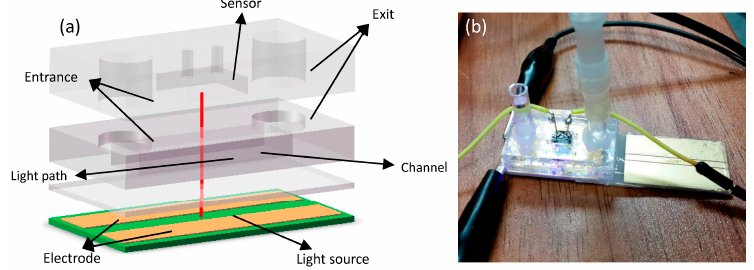
Figure 4. Structure of sensor and channel. Panel ( a ) depicts the sandwich structure made by PMMA, PDMS and PCB; Panel ( b ) shows the entrance connected with a peristaltic pump and tested with applied voltages.